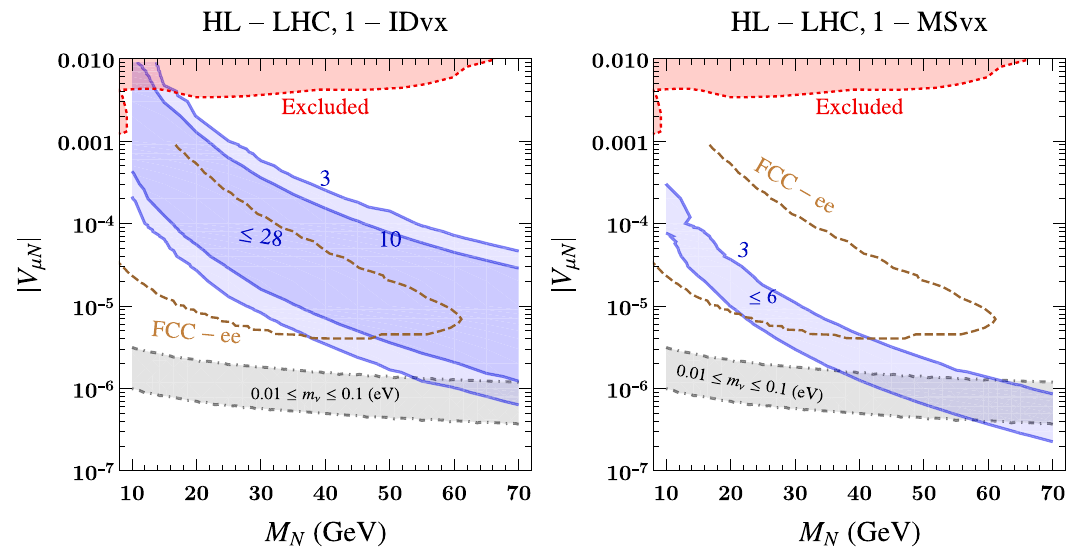
Fig. 12 As Fig. 11, but showing number of 1IDvx (left) and 1MSvx (right) events